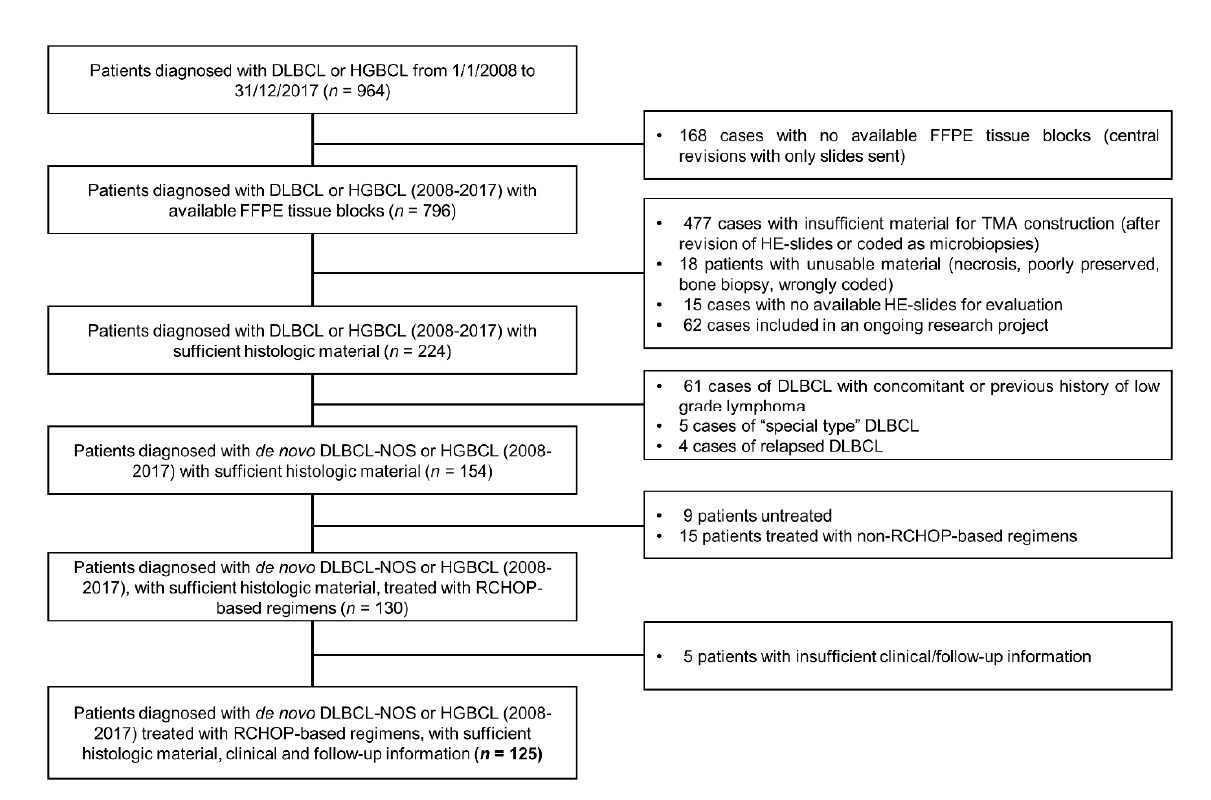
Figure A2. Flow chart of the patients included in the study.